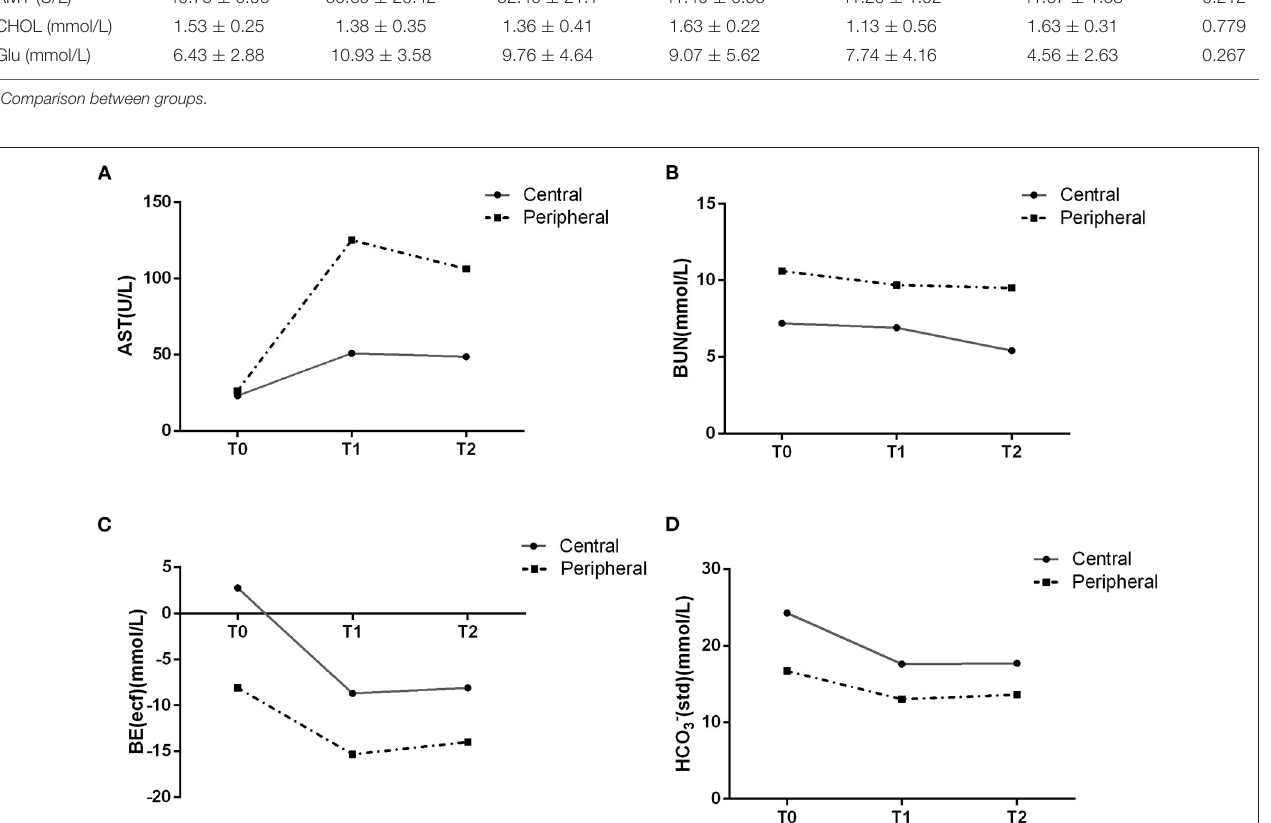
group, suggesting severely interrupted renal perfusion in the peripheral